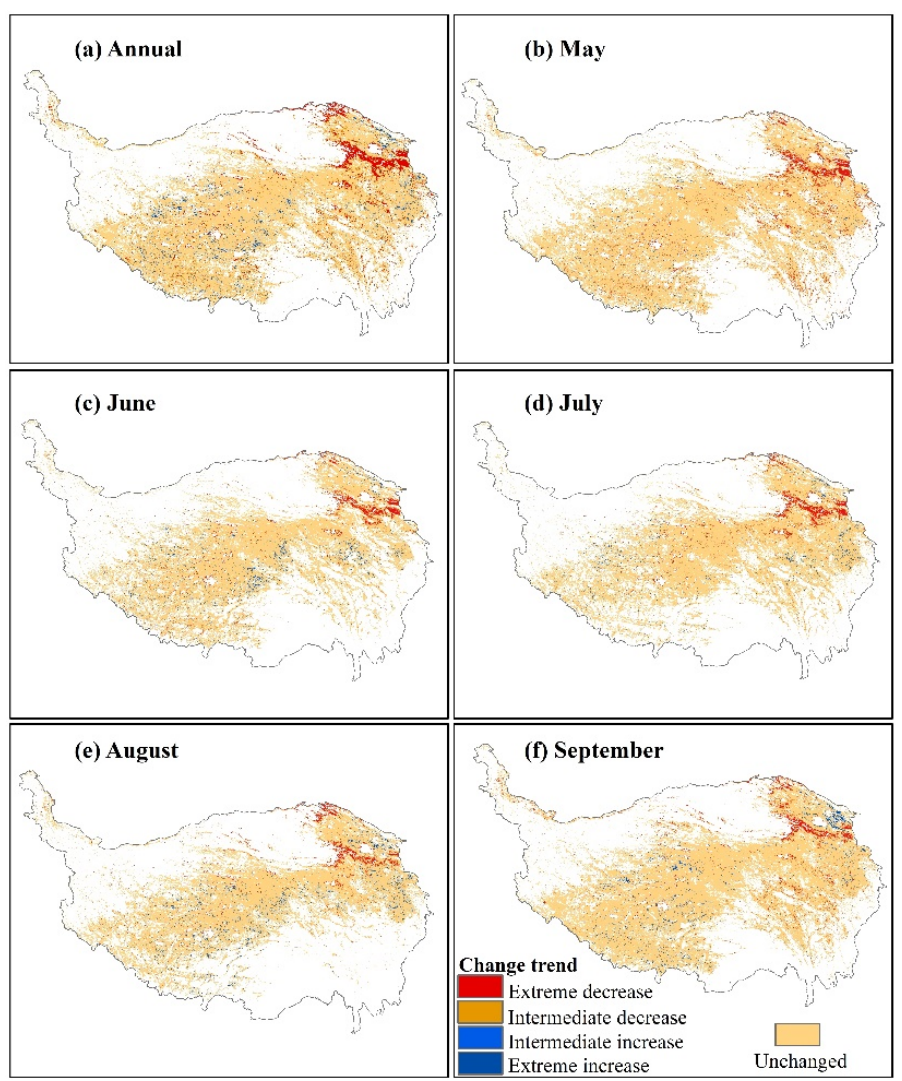
Figure 4. The spatial distribution of albedo change trends in the growing season during 2000–2016. The significant changes include five categories: extreme decrease (slope < 0, p < 0.01); intermediate decrease (slope < 0, 0.01 < p < 0.05); failure to reach a statistically significant level, i.e., unchanged ( p > 0.05); intermediate increase (slope > 0, 0.01 < p < 0.05); extreme decrease (slope > 0, p < 0.01). Table 1. The significant change areas in annual and monthly albedo during 2000–2016 on the QTP, The changes include four categories: extreme decrease (slope < 0, p < 0.01), intermediate decrease (slope < 0, 0.01 < p < 0.05), intermediate increase (slope > 0, 0.01 < p < 0.05), and extreme decrease (slope > 0, p < 0.01).